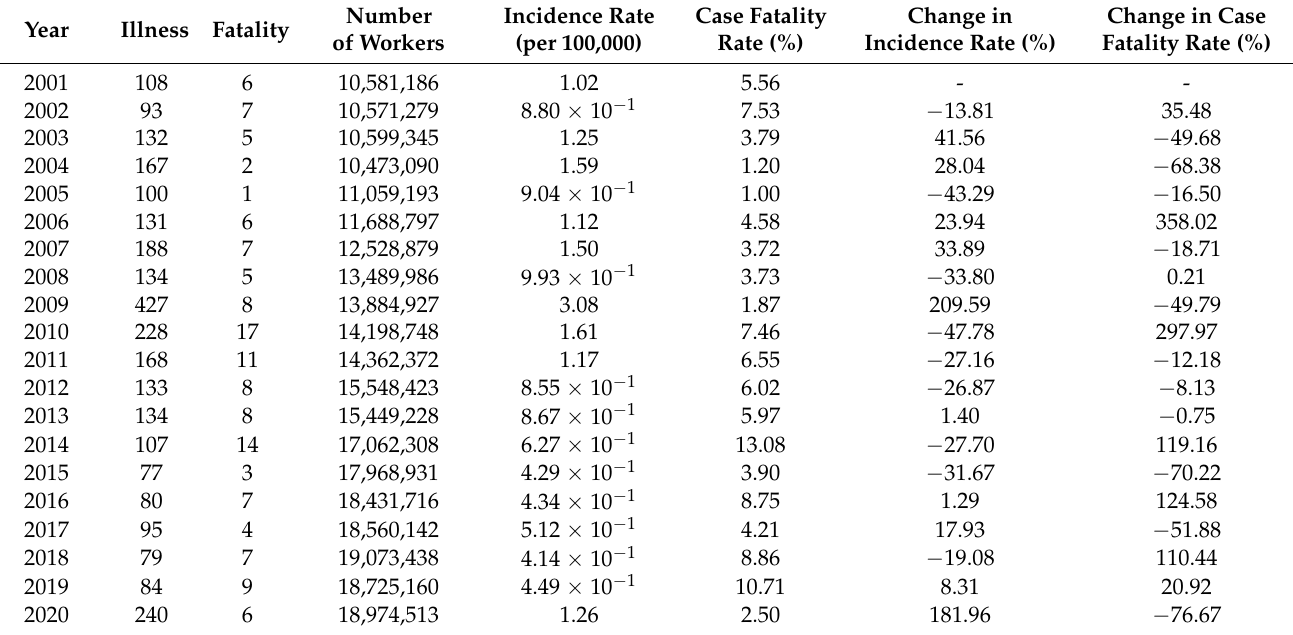
Table 3. Number, rate, and change of rate of illness and fatality of infectious diseases by year according to industrial accident statistics.